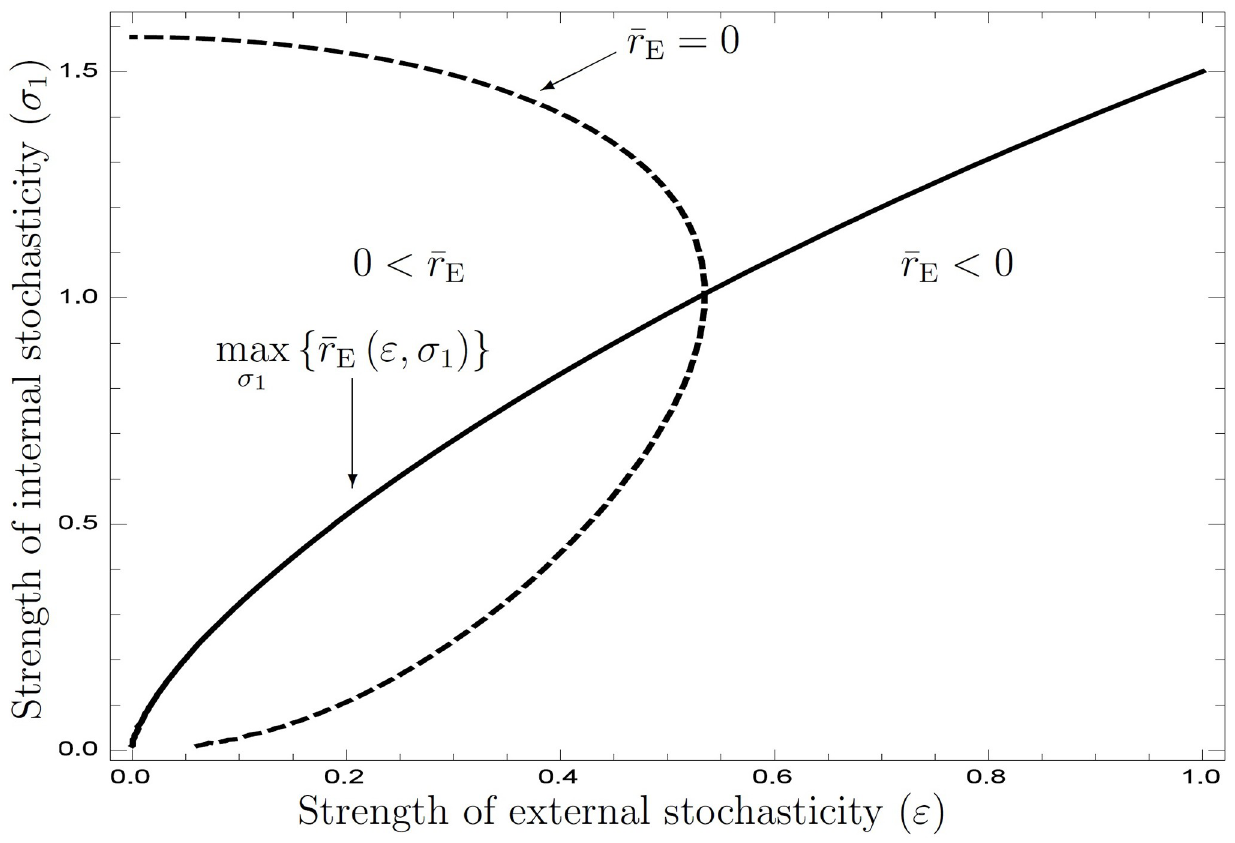
Fig 2. Adaptive heterogeneity under two-fold